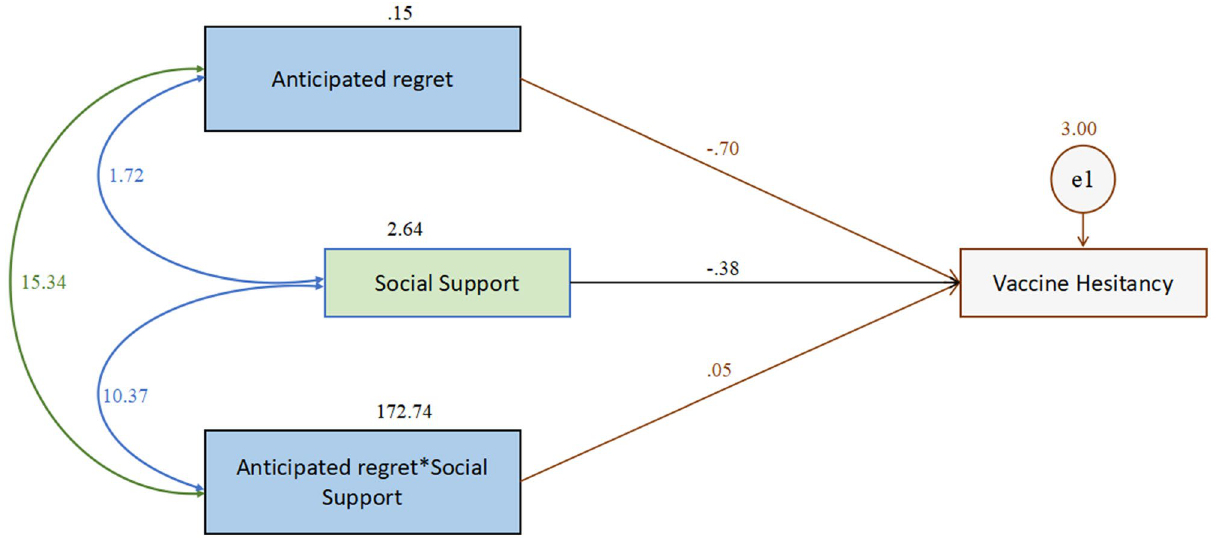
Figure 4. The moderating effect of social support on the relationship between anticipated regret and vaccine